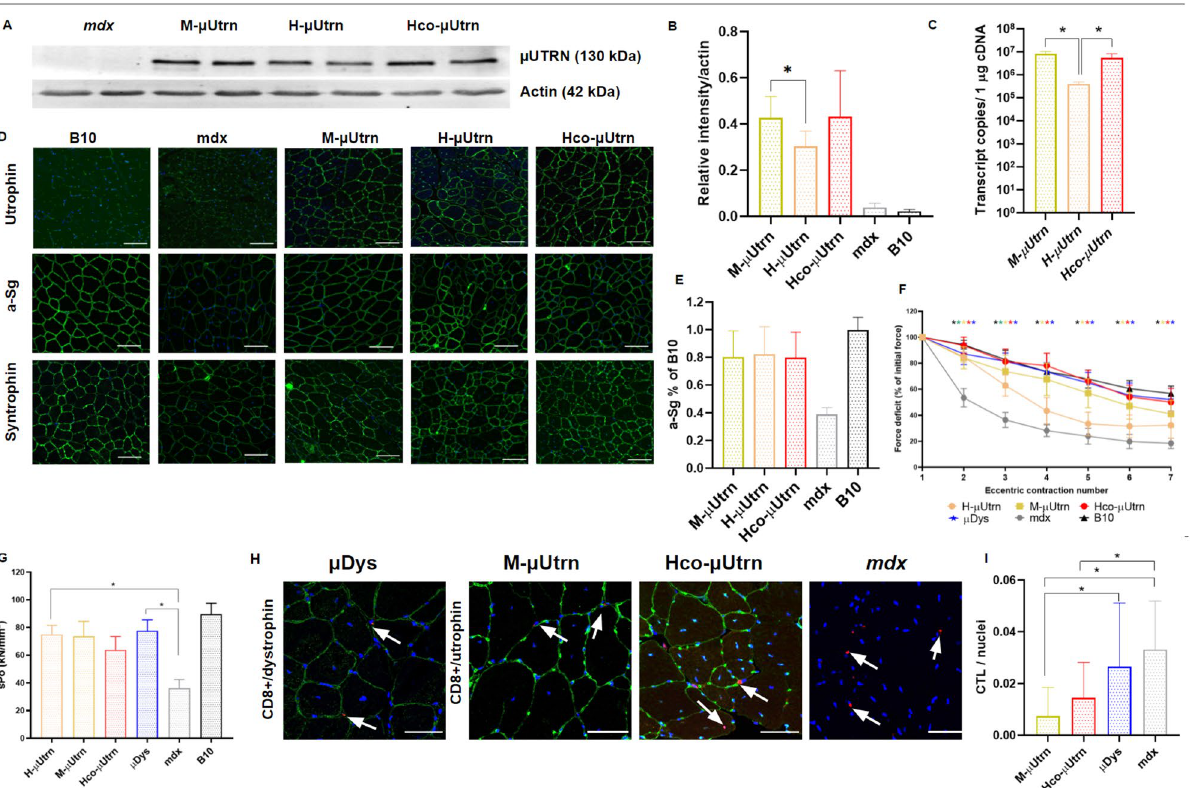
Figure 2. Intramuscular administration of rAAV9-µUtrn at dose 2 × 10 12 vg/TA muscle leads to robust transgene expression and improves the contractile function of the TA muscle in mdx mice after 2 weeks post injection. ( A ) Western blot analysis of recombinant μUtrn expression in tibialis anterior (TA) muscles, with α-actin as the loading control. Unprocessed full-length blots are presented in Supplementary Figure S10. ( B ) Quantitation of µUtrn expression determined via western blot. Data are presented as mean ± SD, * P ≤ 0.05, n = 4/group. ( C ) Analysis of µUtrn transgene expression via RT-qPCR. ( D ) Representative images of native and recombinant utrophin as well as α-sarcoglycan (a-Sg) and α1-syntrophin immunofluorescence in TA muscle cross-sections. Nuclei are counterstained with Hoechst 33,342 (blue). Scale bars, 100 µm. ( E ) Analysis of α-sarcoglycan (a-Sg) expression levels in the sarcolemma of rAAV9-µUtrn-treated muscle in comparison to that in untreated mdx and B10 mice. Data are presented as the mean ± SD, n = 4–10 sections/group. ( F ) Percentage force drop following 20% eccentric contraction and ( G ) specific force of TA muscles from mdx mice administered rAAV9-µUtrn as compared to that in vehicle control mice. Values in ( C, F ), and ( G ) are presented as the mean ± SEM (N = 8 TA muscles for each group), and statistical significance was set at P ≤ 0.05. ( H ) Representative images of CD8 + cytotoxic T-lymphocyte immunofluorescence (red dots marked with white arrows) in TA muscle sections. µUtrn and µDys in the sarcolemma were stained in green, while nuclei were stained in blue. Scale bar, 50 μm. ( I ) Quantitation of CD8 + CTLs in TA muscle sections. CTL number normalized per nuclei, reflecting the cross-sectional area. Values are expressed as the mean ± SD, n = 11–55 sections analyzed per